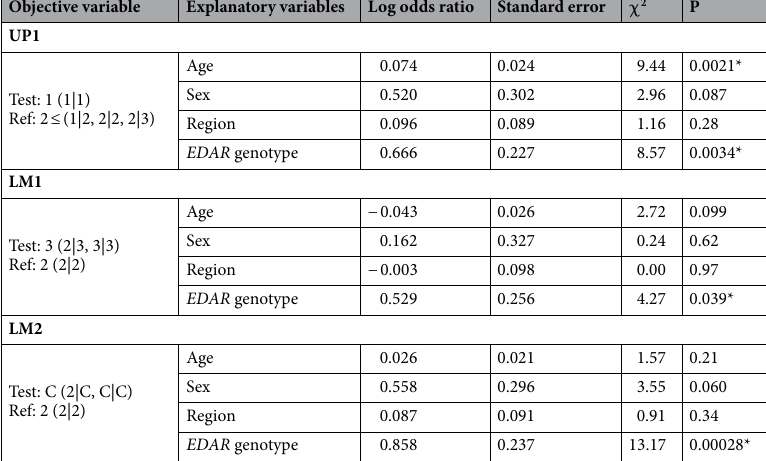
Objective variable Explanatory variables Log odds ratio Standard error χ 2